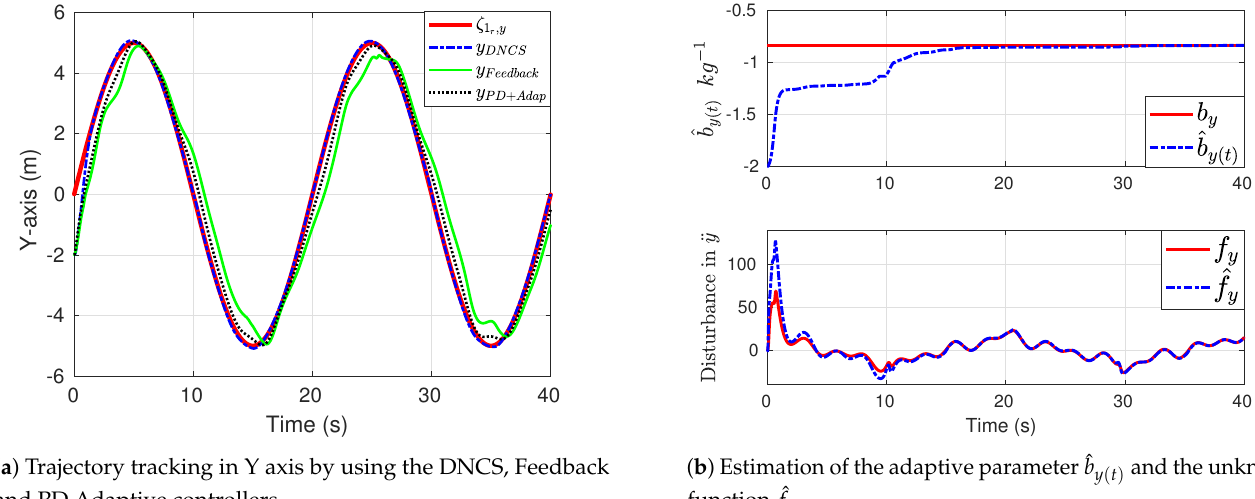
( b ) Estimation of the adaptive parameter ˆ b y ( t ) and the unknown function ˆ f y . Figure 7. Simulation results for trajectory tracking of a 3D helical reference signal in Y axis.